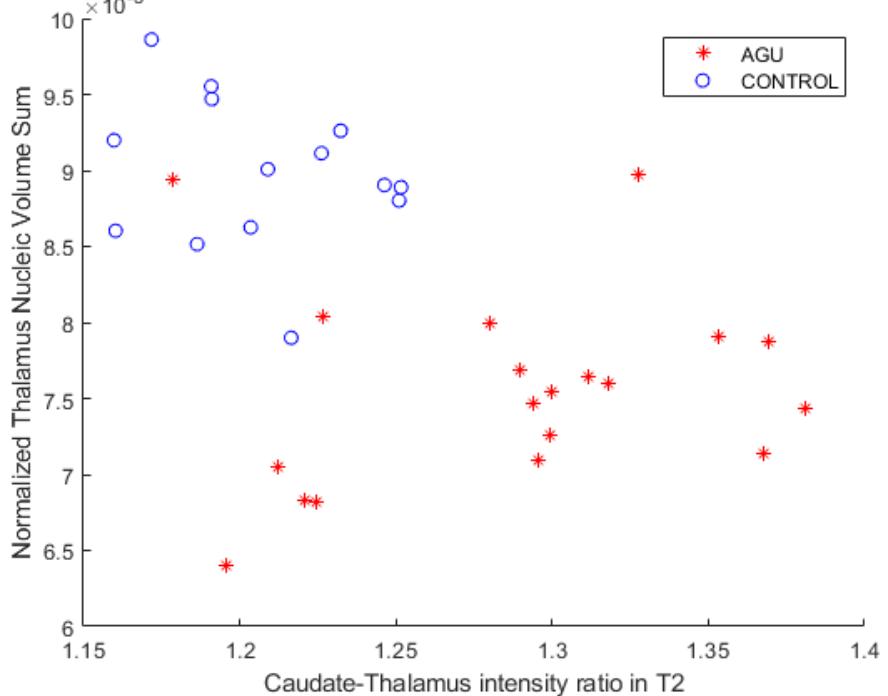
Figure 2. Normalized total thalamus volume (as sum of thalamus nucleic volumes) plotted against caudate-thalamus intensity ratio in the T2-weighted images. The patients and the controls were less separated by the x -axis than the y -axis.